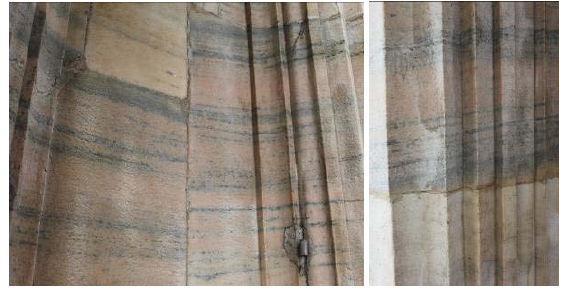
Figure 3: Typical Candoglia marble blocks on the